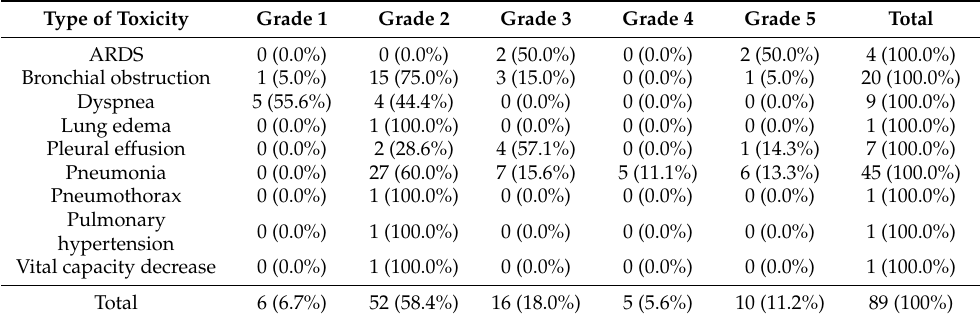
Table 3. Overview of pulmonary toxicities and their respective grades. Percentage numbers in parentheses indicate the fraction of the respective grade for a given toxicity. ARDS: acute respiratory distress